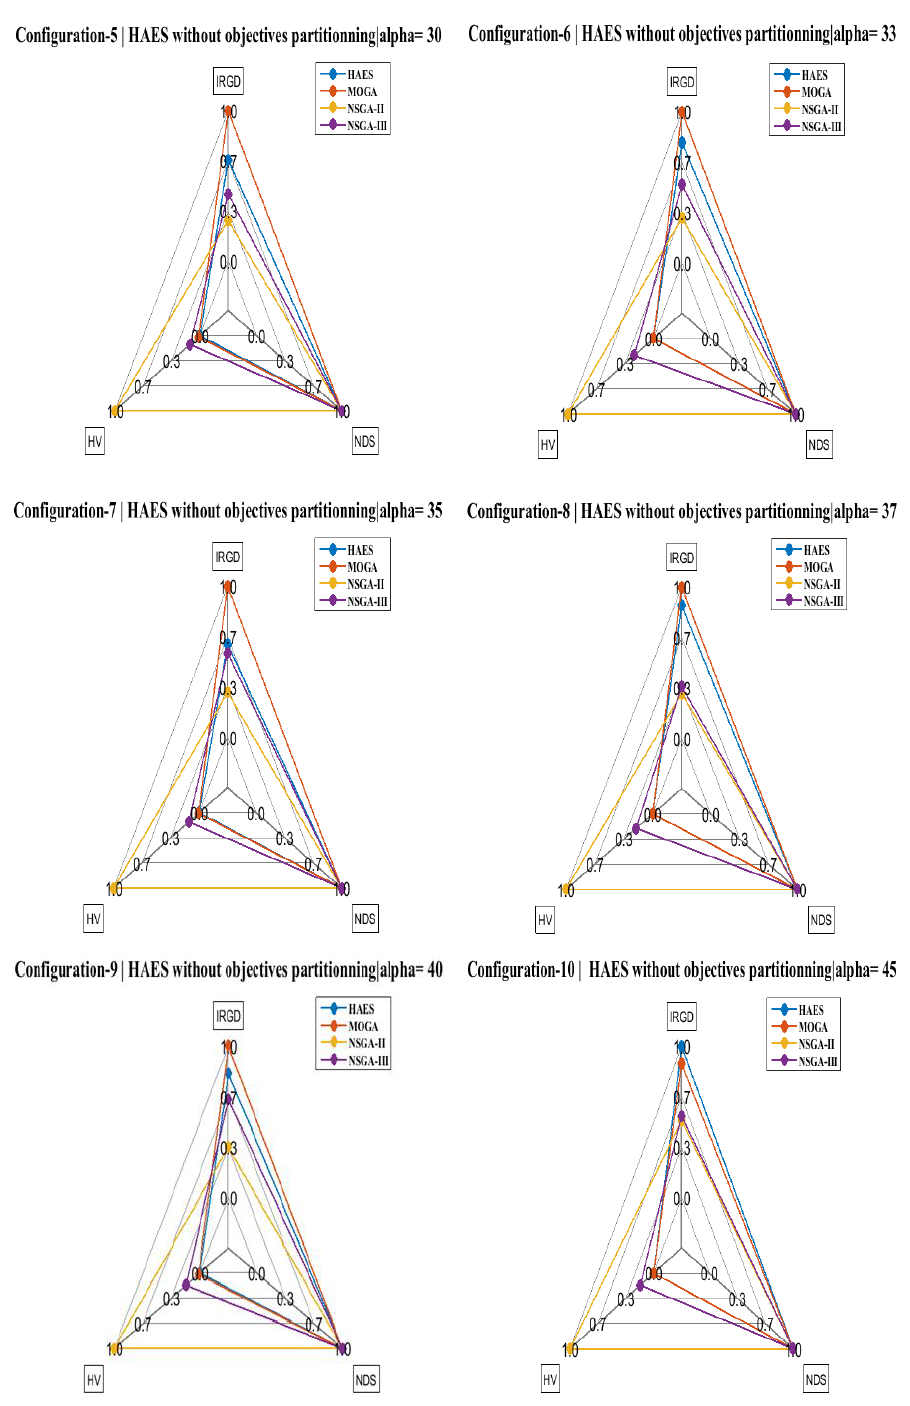
Figure 6. Comparison between HAES different configurations in terms of alpha and the other algorithms.